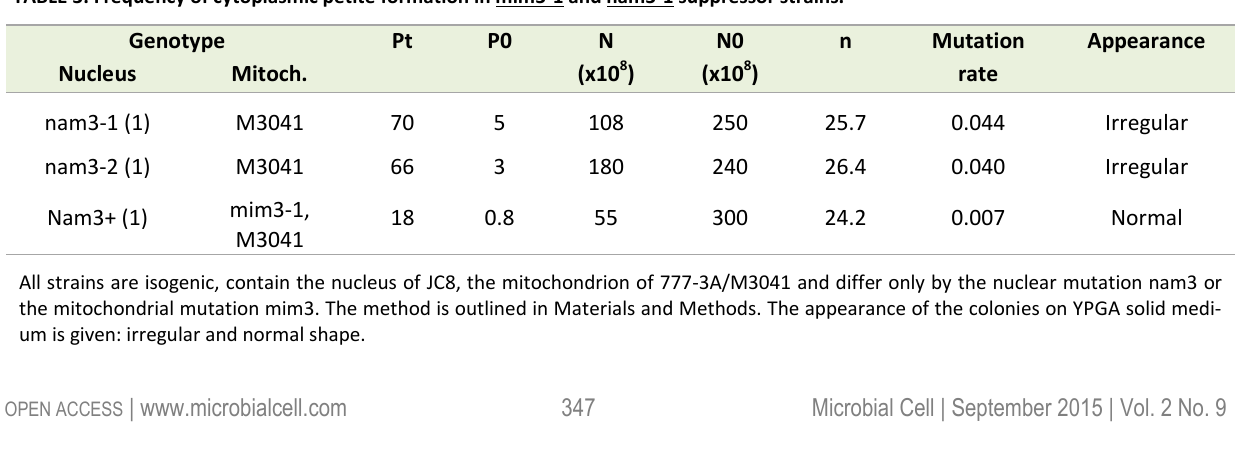
TABLE 3. Frequency of cytoplasmic petite formation in mim3-1 and nam3-1 suppressor strains.